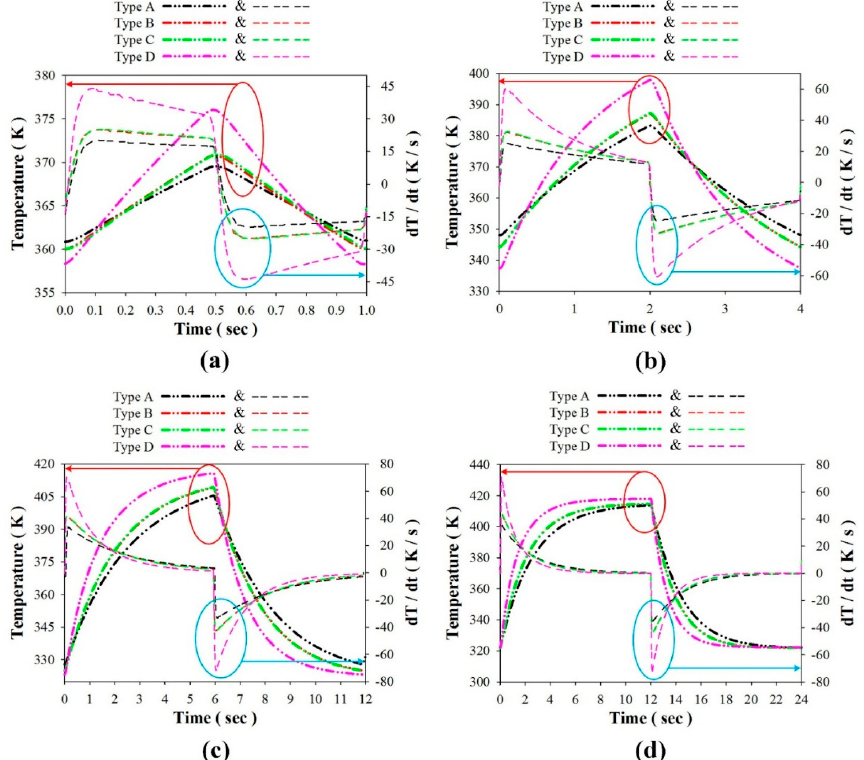
Figure 8. Temperature variation rate as a function of the temperature and time for using the PZT cells with various structures (Types A to D) and periods of about ( a ) 1 s; ( b ) 4 s; ( c ) 12 s; and ( d ) 24 s.